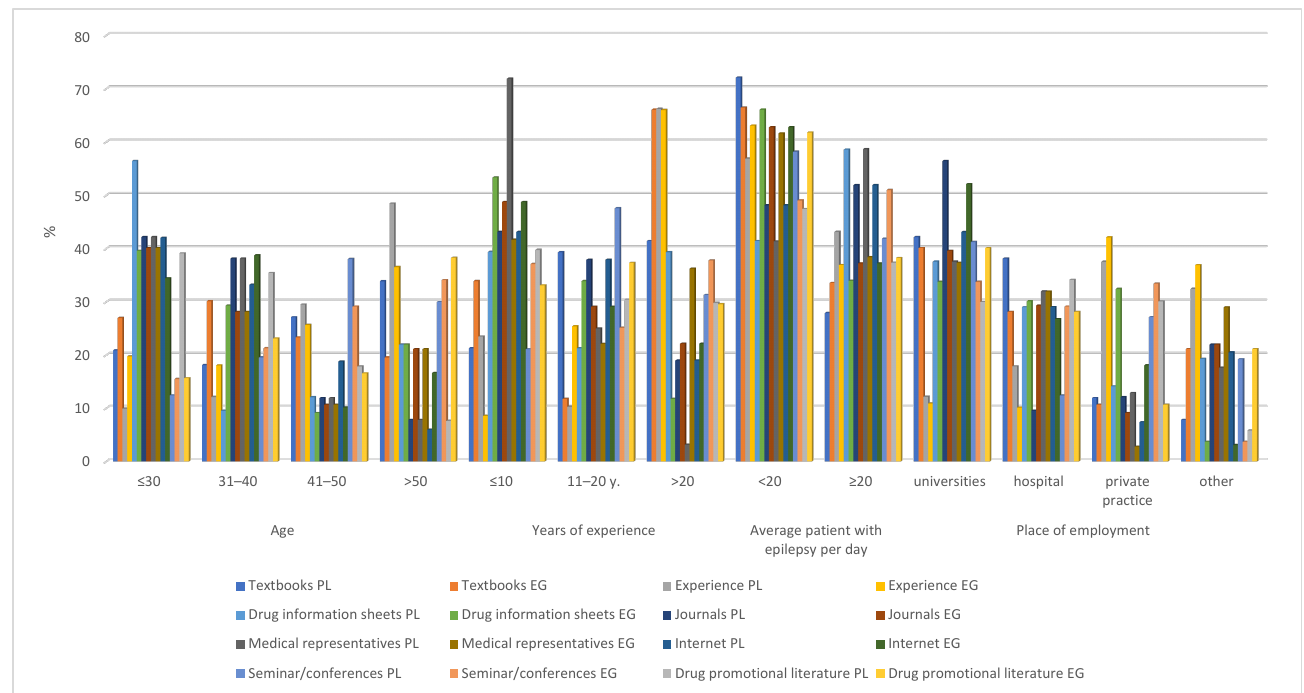
Figure 2 . The main sources used to gather information about adverse drug reactions. Figure 2. The main sources used to gather information about adverse drug